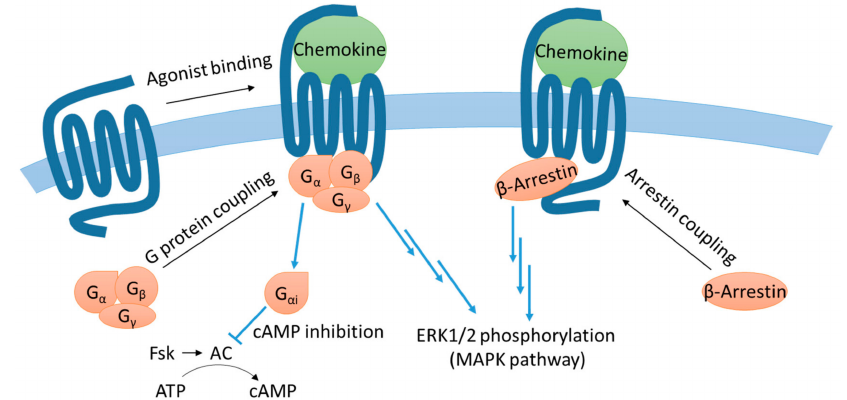
Figure A1. Simplified diagram of the signaling assays measured. Chemokine recognition induces conformational change(s) in the receptor. The ensemble of activated GPCR conformations is dependent on the agonist bound on the extracellular side and determines which intracellular e ff ectors, such as G proteins or Arrestins, are preferentially recognized to induce further downstream signaling. Common GPCR signaling pathways include ERK1 / 2 phosphorylation through activation of the mitogen activated protein kinases (MAPK) pathway and G α i -mediated cAMP inhibition following trimeric G protein dissociation. The specific pathway giving rise to ERK1 / 2 phosphorylation may vary depending on the cellular context. Here we used forskolin (Fsk) to directly stimulate cAMP production via activation of adenylyl cyclase (AC).